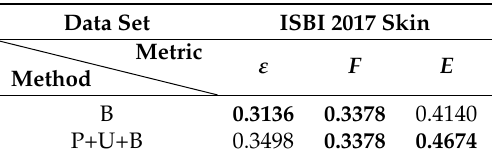
Table 4. The performance comparison of the strong baseline model (B, for backpropagation only) and our proposed PUB-SalNet under three metrics on the ISBI Challenge [27]. ε , F and E are the same as in Table 1. The best performance of each metric is in bold